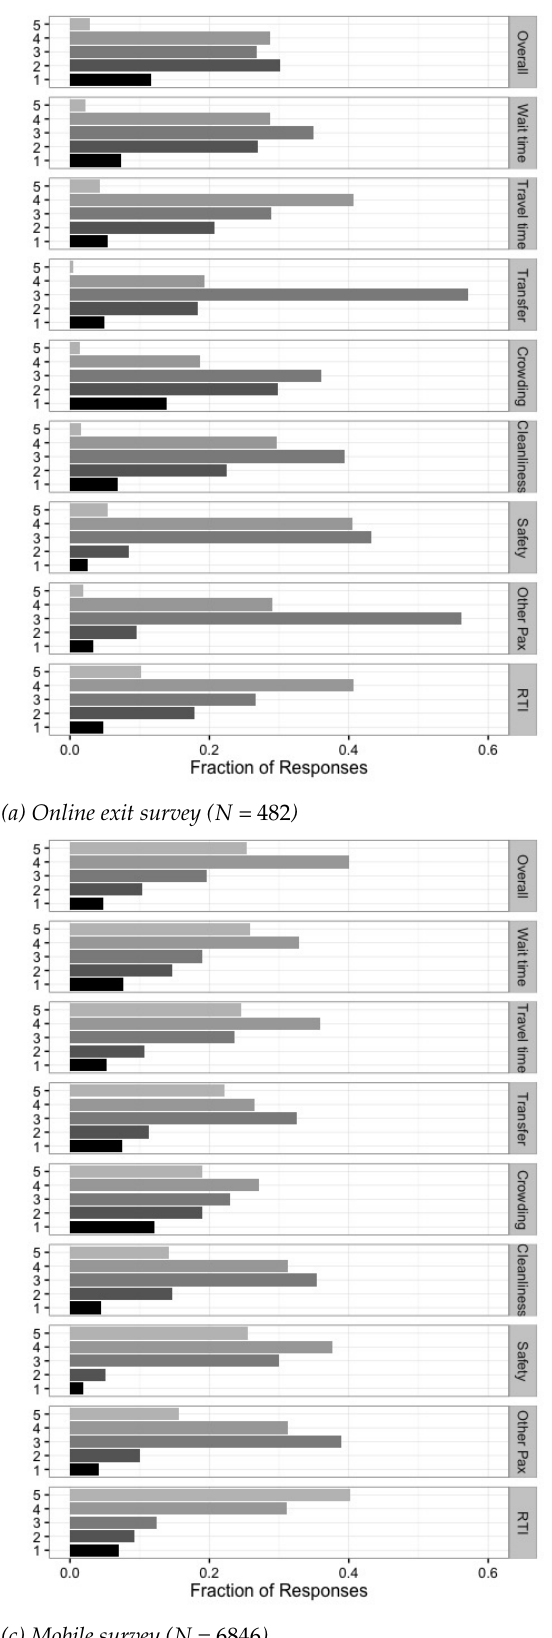
Figure 2. Distribution of survey responses. RTI stands for Real-Time